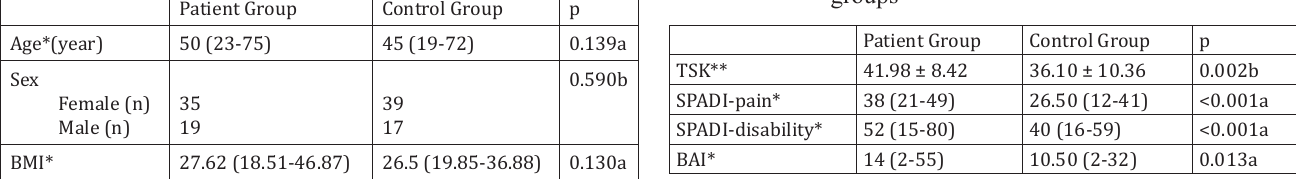
Comparison of Age, Sex and BMI between Patient and Control Groups